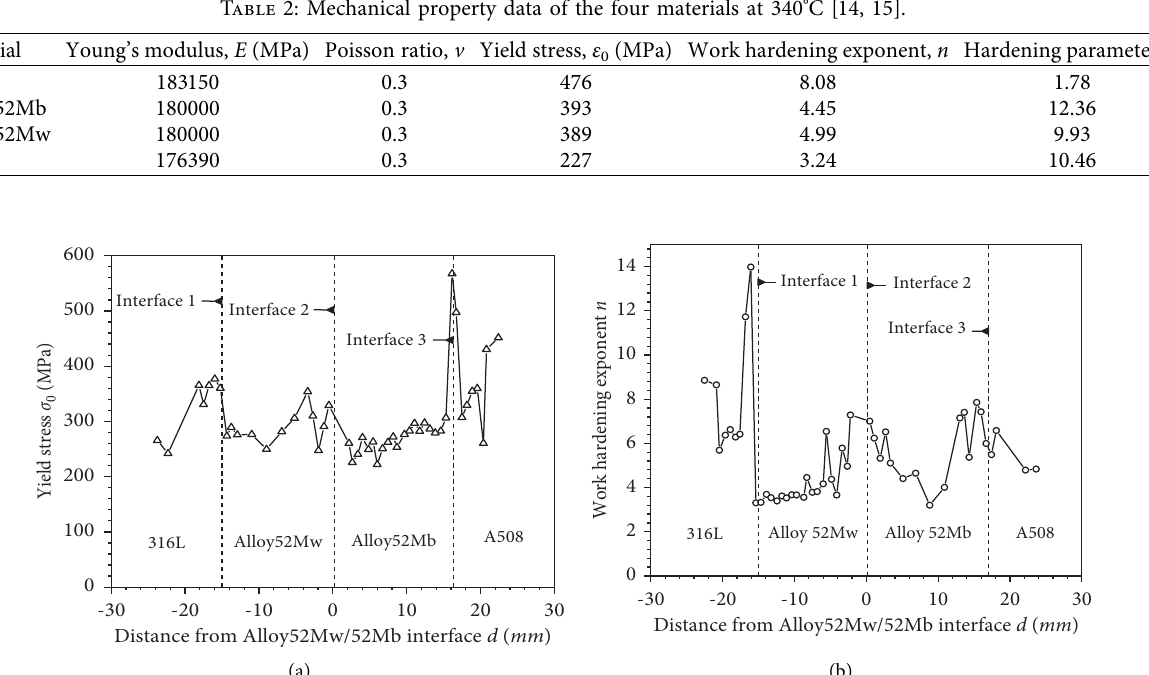
Figure 3: Local mechanical properties distribution of the Alloy 52M DMWJ. (a) Yield strength and (b) work hardening exponent [14,